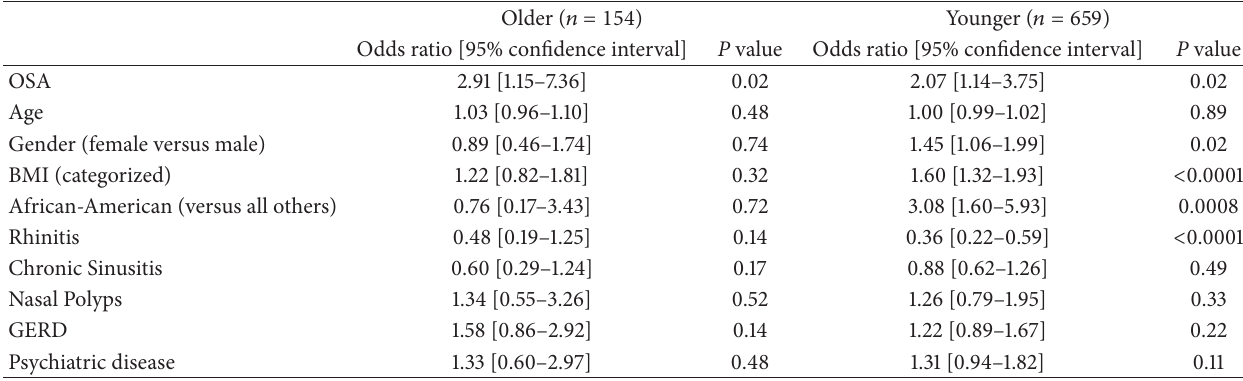
Table 6: Multivariate associations of asthma severity step with OSA (clinically-diagnosed and untreated) and other traditional factors of asthma control, in the older and younger asthma subjects.